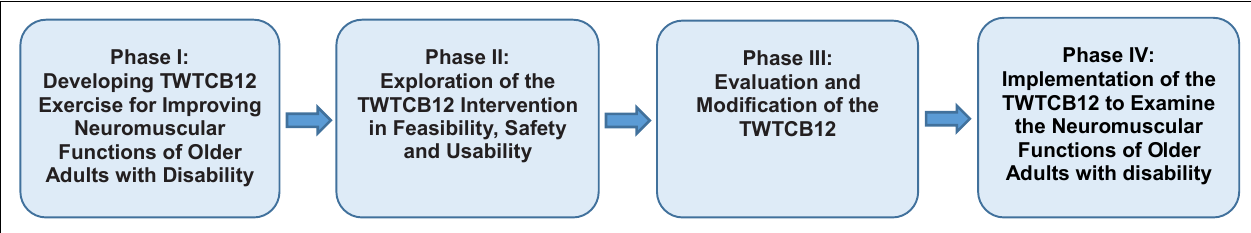
FIGURE 2 | Medical Research Council (MRC) framework for TWTCB12 intervention in four phases for improvement of neuromuscular functions for older adults with disability modified conceptual framework based on the model of Craig et al. (2013).